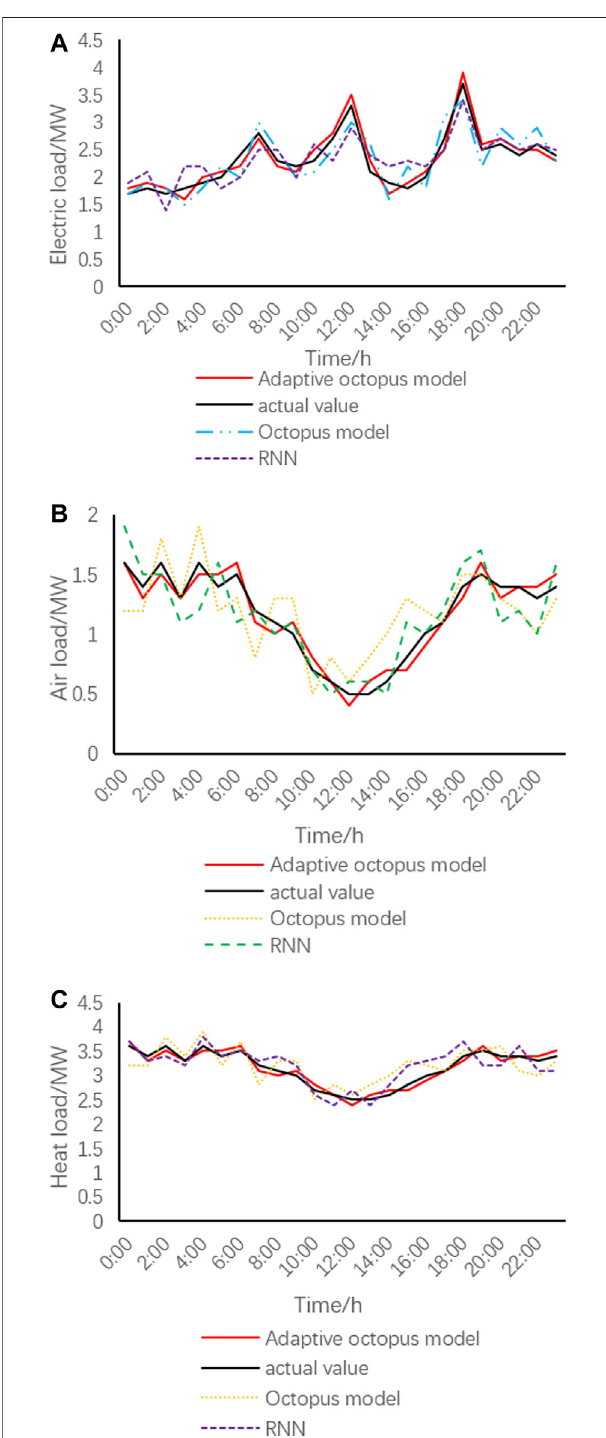
FIGURE 7 | Comprehensive energy short-term daily load forecast where y is the predicted value of the i th sample; x i is the feature vector i of the i th data point, f k is the structure q of the k th tree and the leaf weight w, K is the number of trees, and F is the collection space of trees.